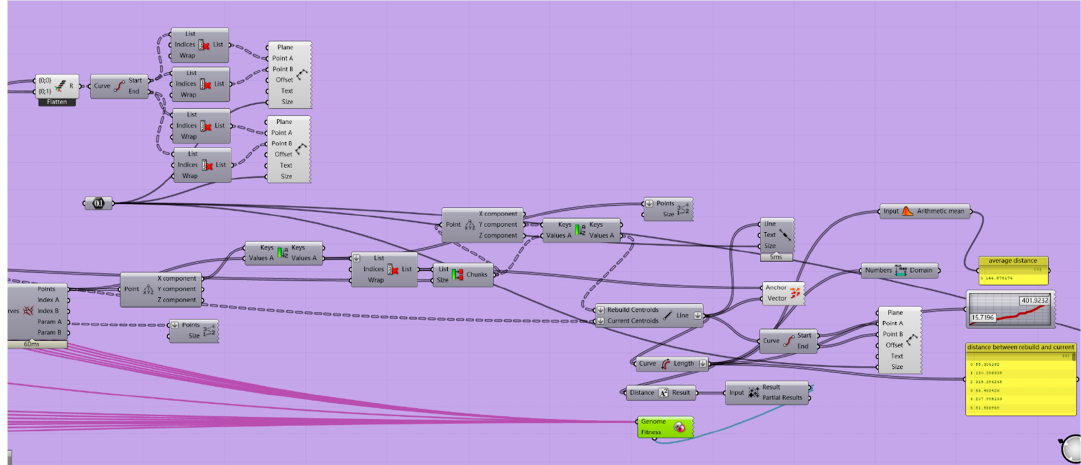
Figure 6. A candidate solution of generating axes and numerical analysis of this moment.